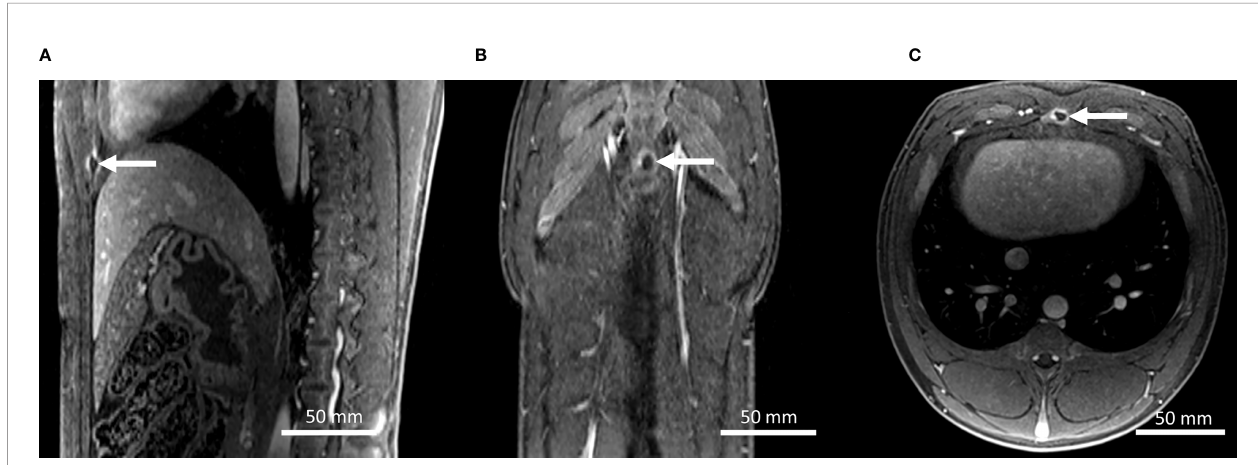
FIGURE 8 | (A – C) Gd-enhanced high-resolution T1w MR images in the coronal, axial, and sagittal planes on pig #1, 7 days after the HIFU treatment. A small thermal lesion on the sternum is observed (arrows).